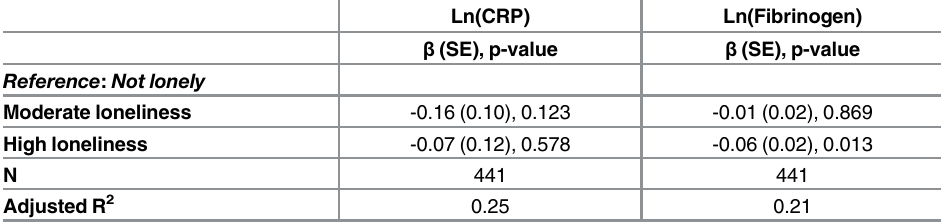
Table 3. Association between categories of loneliness and inflammatory